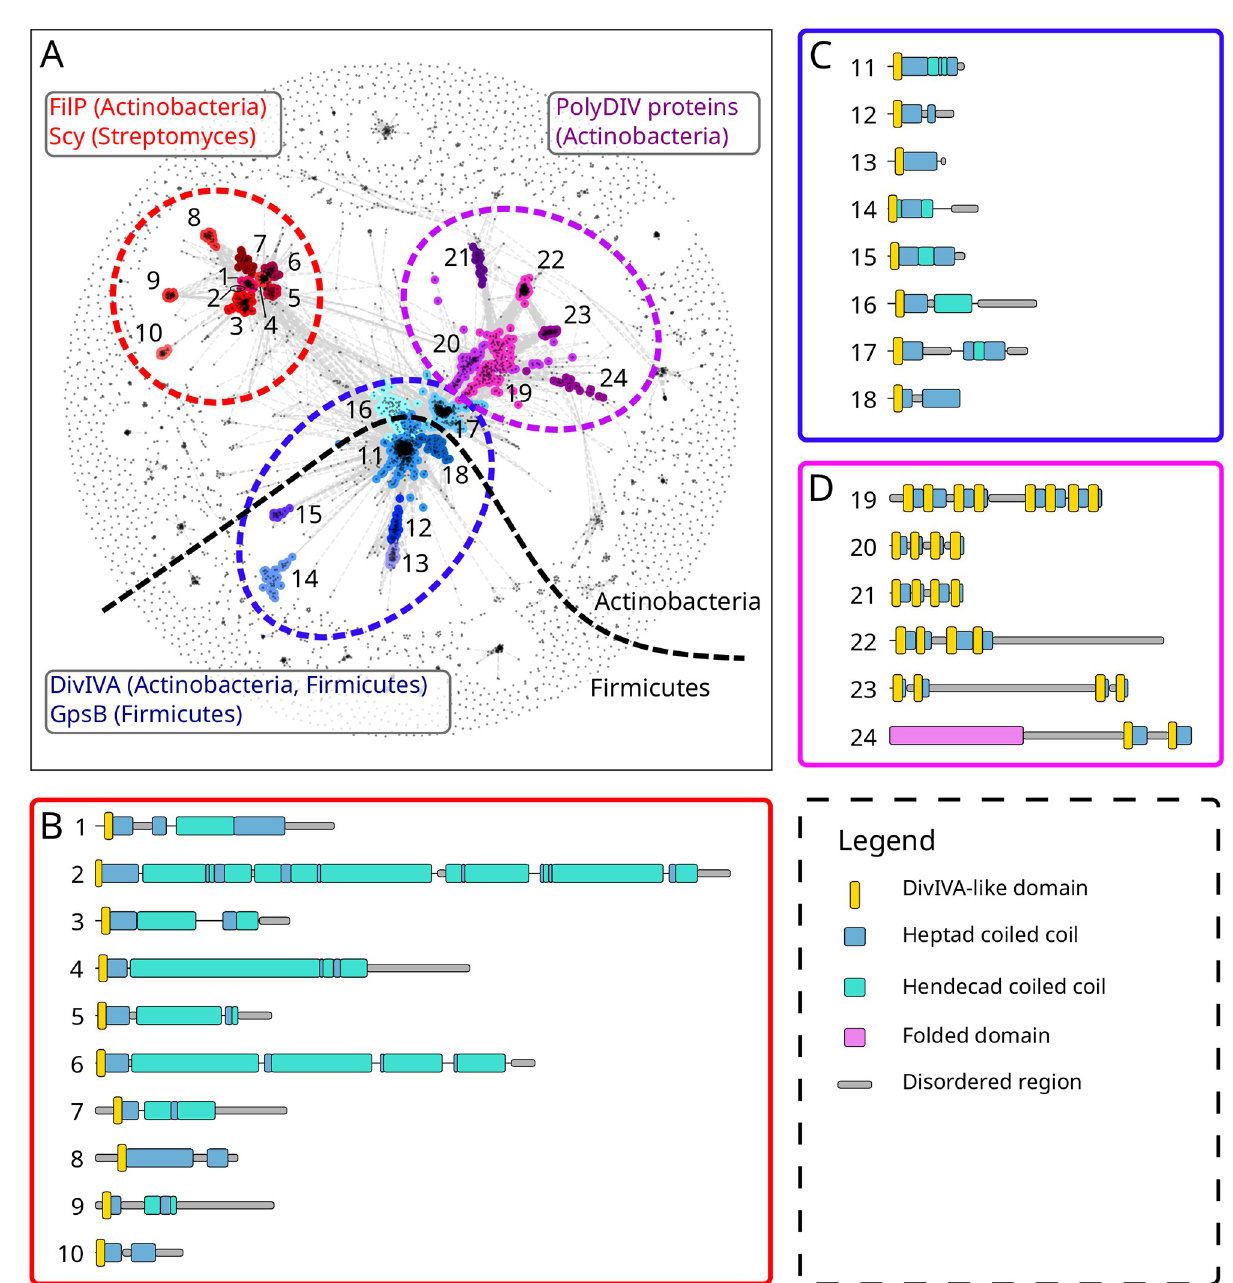
Fig 2. A broad survey of DivIVA-like proteins. (A) Cluster map of sequences with a match to the conserved motif in DivIVA-like proteins (see Methods). Clustering was done in 2D until equilibrium at a BLAST P-value of 1E-10. Connections represent similarities up to a P-value of 1E–10. The three groups of clusters that feature a DivIVA-like domain are colored and labeled. Cartoon representation of the sequence features for representative sequences of Scy/FilP (B), DivIVA/GpsB (C), and PolyDIV groups (D). geodermatophilales, micromonosporales and pseudonocardiales). All the sequences in the FilP/Scy group show the same domain organization, but differ substantially in length, from under 200 residues to over 1000 (Fig 2B). All clusters show a preference for R before GYD, except for one of the uncharacterized clusters, where F or T are preferred. Surprisingly, Scy